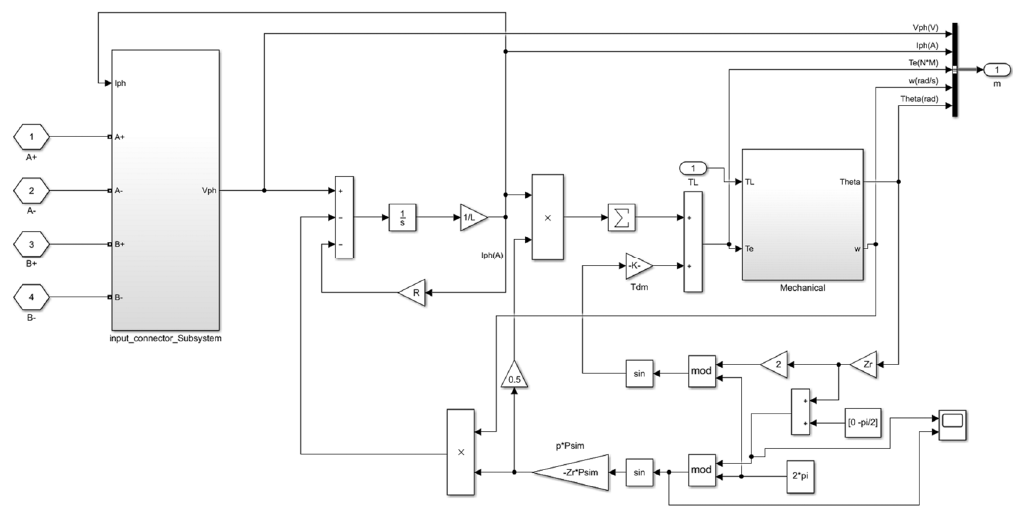
Figure 6. Model of cutter height adjustment system from the ground.